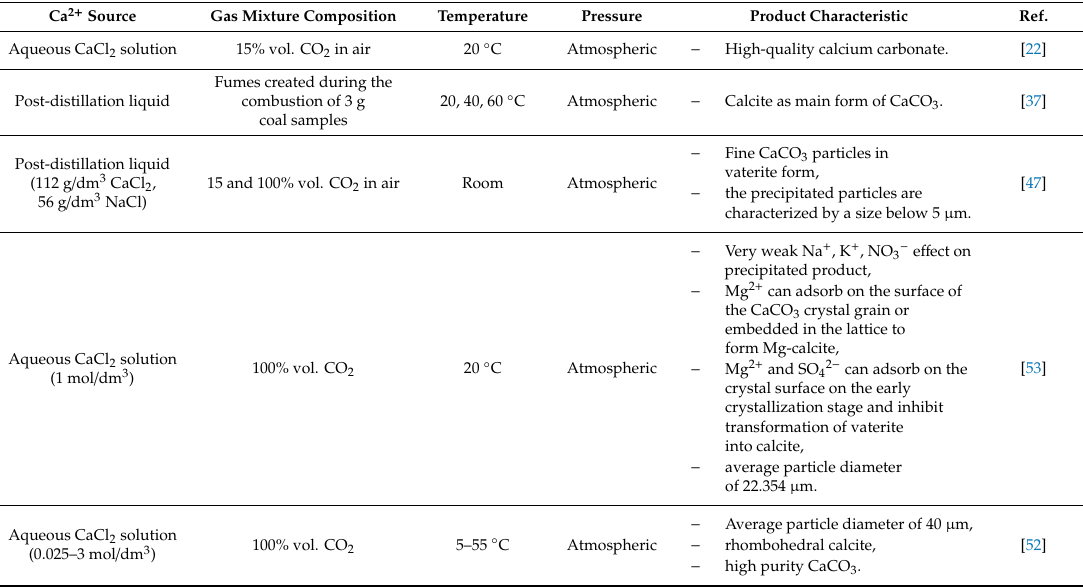
Table 2. Process parameters of CaCO 3 precipitation technologies for Solvay post-distillation liquid utilization using carbonation